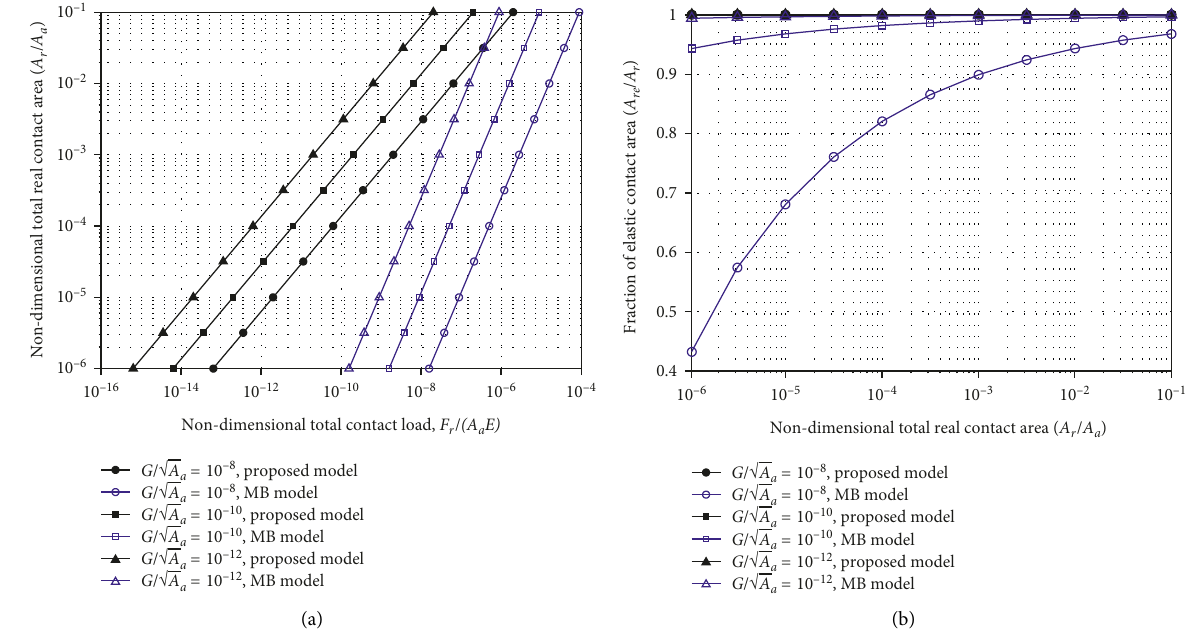
Figure 12: Comparison of the proposed model and the MB model (a) on the relationship between nondimensional total contact load and nondimensional total real contact area and (b) on the relationship between nondimensional total real contact area and the fraction of elastic � 24, n � 50, D � 1 . 5, Y / E � 0 . 01). contact area for different roughness parameters ( n max max